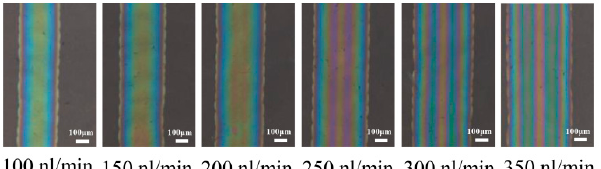
Figure 7. E ff ect of the velocity of substrate on the organic micro-pattern width. Figure 7. Effect of the velocity of substrate on the organic micro-pattern width.